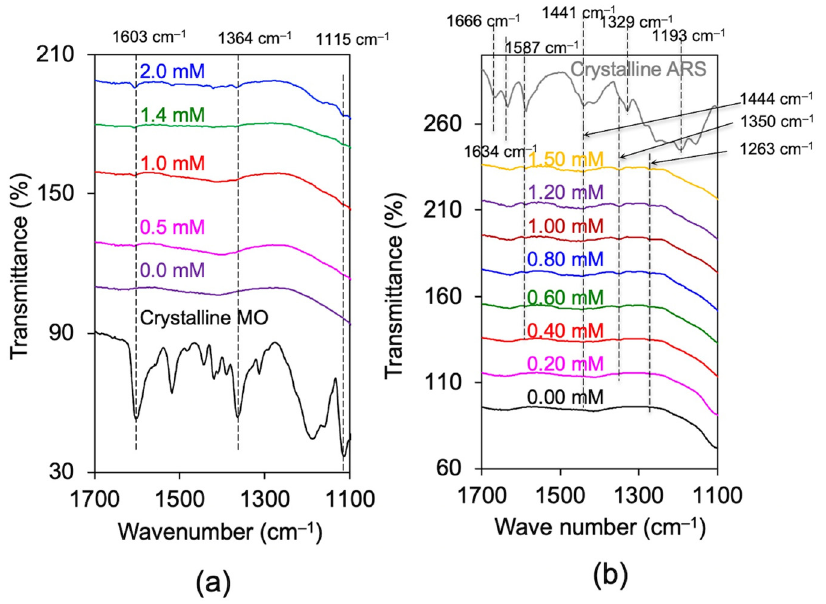
Figure 5. FTIR spectra of zeolite in the wave number of 1100–1700 cm –1 after MO ( a ) and ARS ( b ) sorption from different initial concentrations.